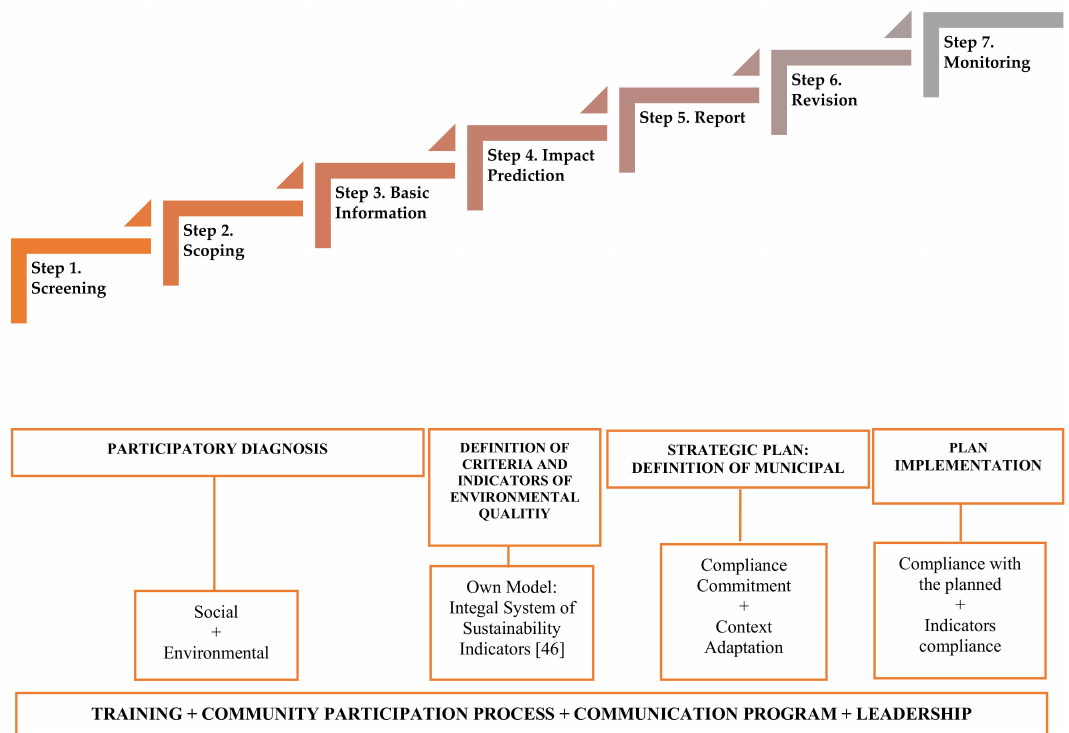
Figure 6. SEE model for participatory municipal management applied in our case study